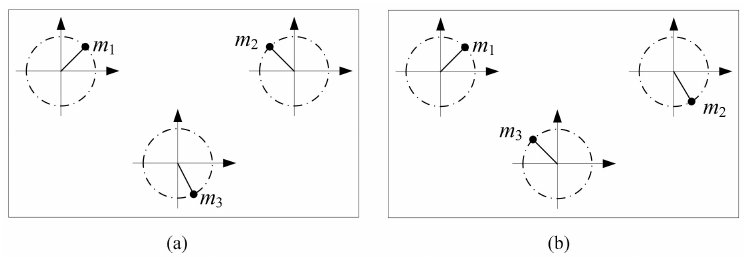
Figure 8. Motion stateof threeERs using vibrationsynchronization: ( a ) onemoment; ( b ) anothermoment. To provide the basis for the master-slave control scheme, we assume two-thirds of ERs have achieved control synchronization to study the change of the phase difference.